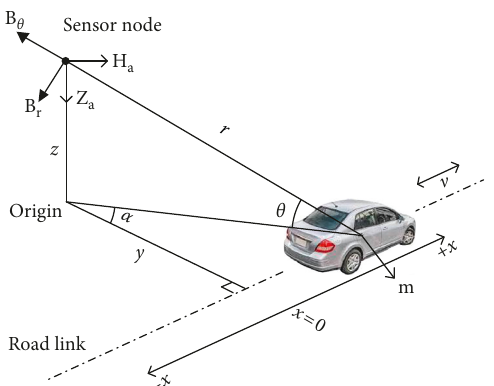
and radial B r θ